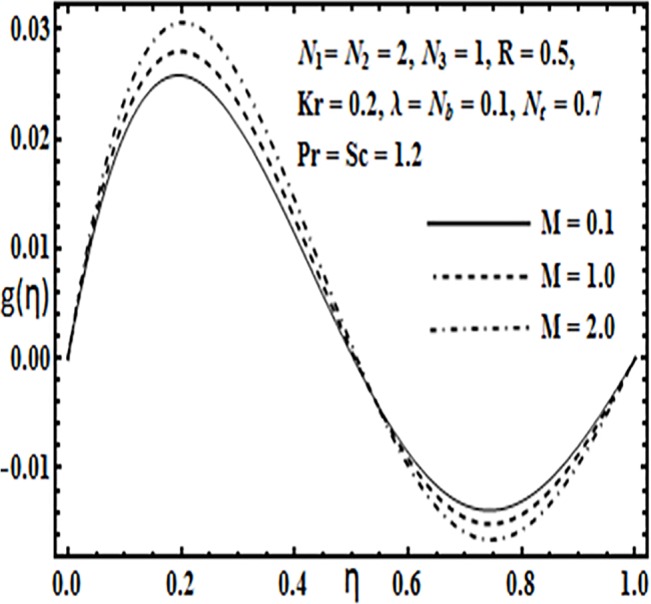
Effect of M on g(η).